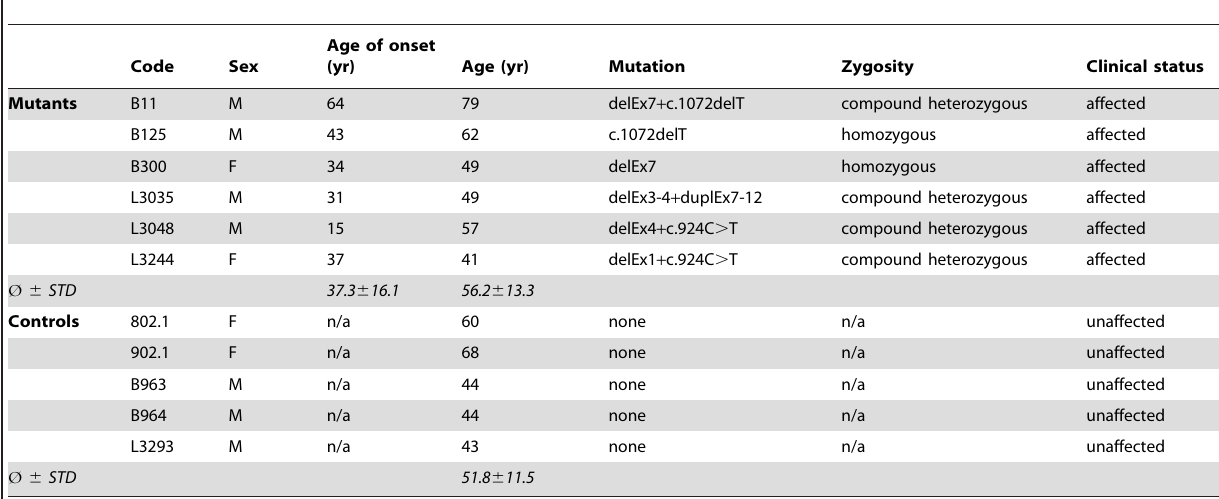
Table 1. Genotypic and phenotypic characterisation of investigated